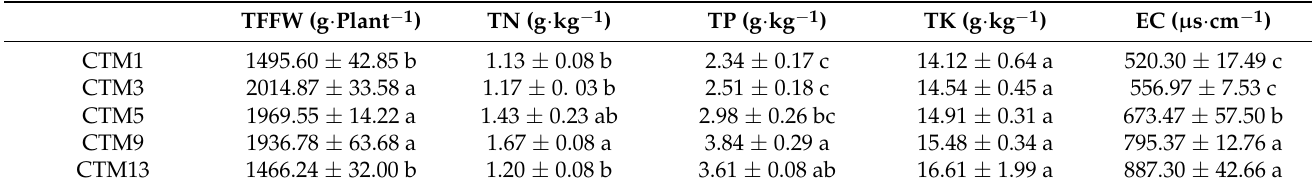
Table 1. Tomato Fruit fresh per plant and soil chemical properties among different CTM